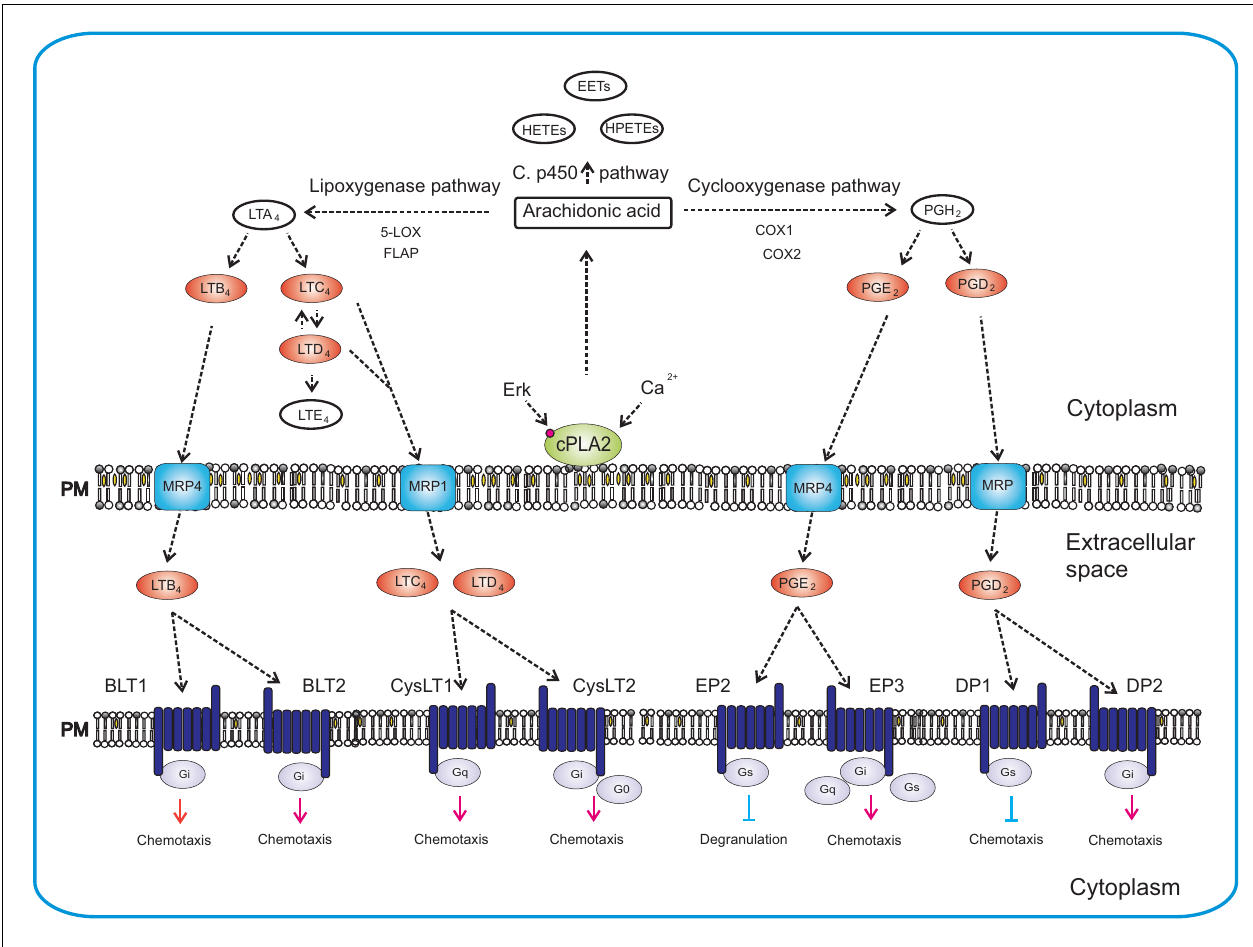
FIGURE 4 | Synthesis of eicosanoids and their actions in mast cells. Synthesis of eicosanoids is initiated by activation of cPLA2 via Erk-dependent pathway, followed by Ca 2 + -dependent translocation of cPLA2 to the plasma membrane where it liberates the arachidonic acid. Free arachidonic acid can be metabolized by three independent pathways: lipoxygenase pathway, cyclooxygenase pathway and cytochrome P450 monooxygenase pathway. The 5-lipoxygenase in cooperation with FLAP mediates transition of arachidonic acid to unstable LTA 4 . LTA 4 is subsequently converted to LTB 4 , LTC 4 , and LTD 4 . In the cyclooxygenase pathway, arachidonic acid is converted to intermediate PGH 2 by peroxidase activity of COX enzymes. PGH 2 is